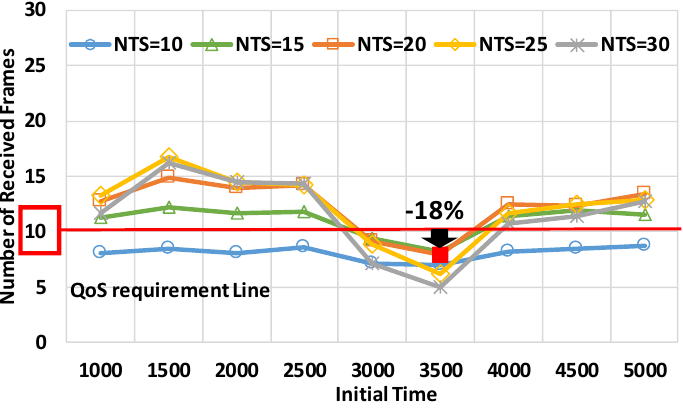
Figure 11. The number of received frames in the small intersection.